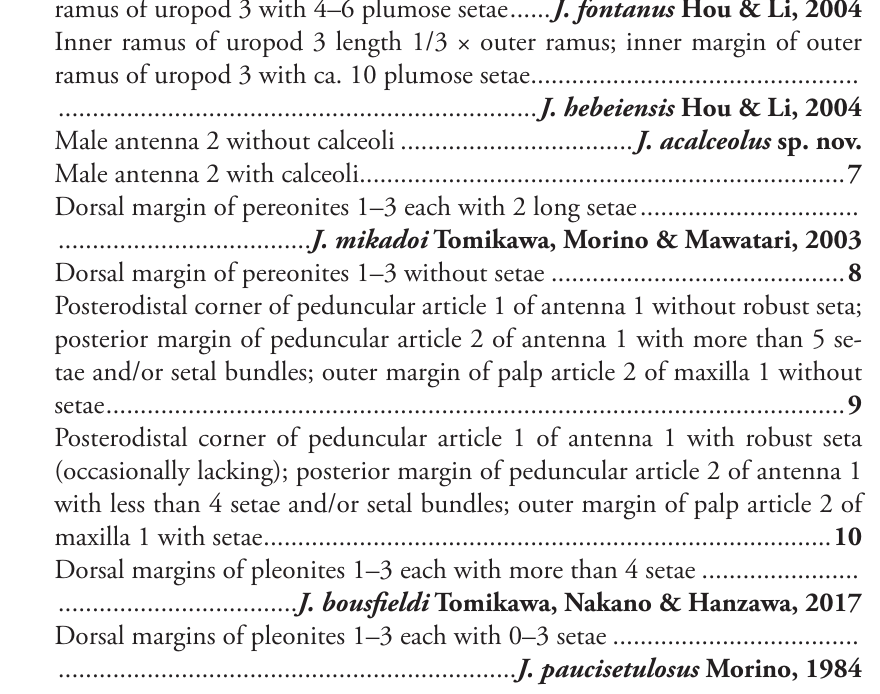
Inner ramus of uropod 3 length 1/4 × outer ramus; inner margin of outer ramus of uropod 3 with 4–6 plumose setae ...... J. fontanus Hou & Li, 2004